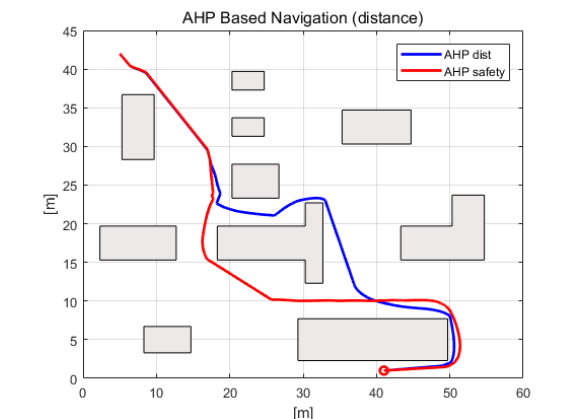
Figure 10. Comparison between short distance and high safety relative importance matrix (RM) based AHP path planning.